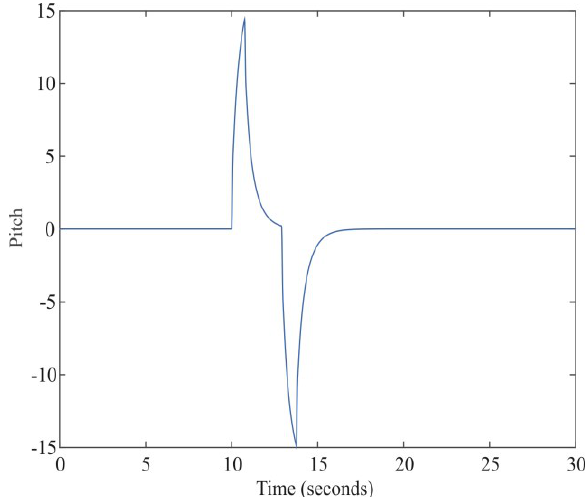
Fig. 12. The response of the object using a cascade controller (direction of Pitch)